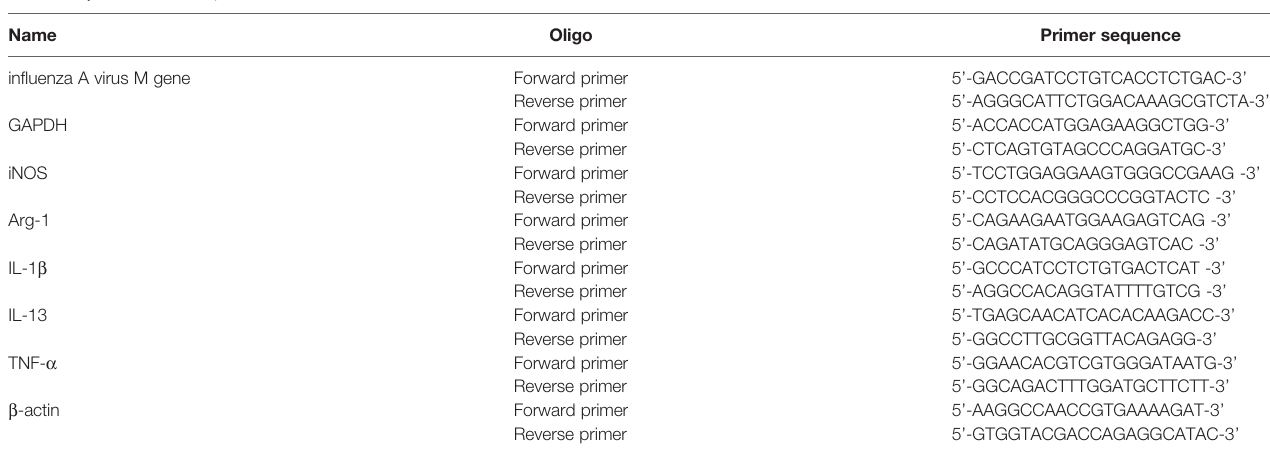
TABLE 1 | Real-time PCR